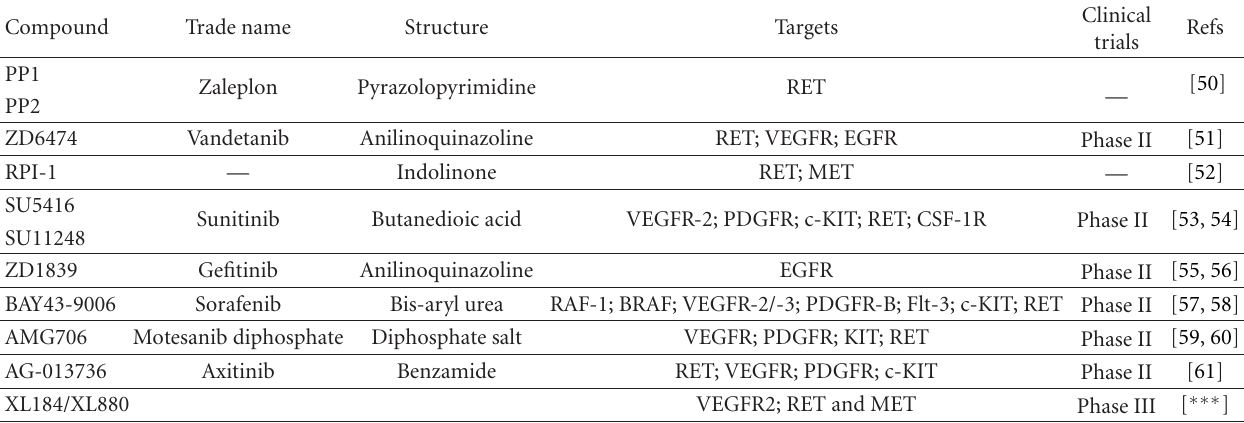
Table 1: Molecules used in preclinical and clinical trials as RET tyrosine kinase